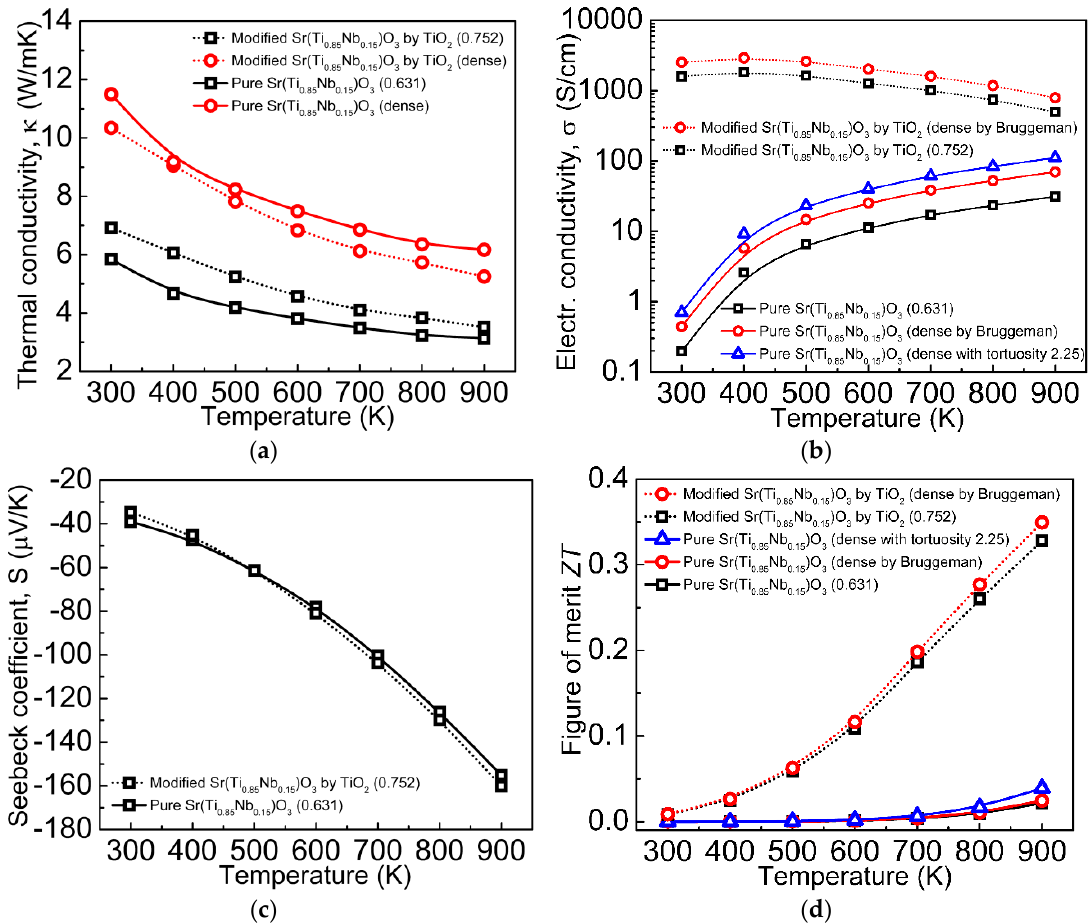
Figure 9. Temperature-dependent thermoelectric properties of Nb − SrTiO 3 ceramics obtained from submicron Sr(Ti 0.85 Nb 0.15 )O 3 powder either modified or non-modified with TiO 2 : ( a ) Thermal conductivity; ( b ) Electrical conductivity; ( c ) Seebeck coefficient; ( d ) Figure of merit ZT . © 2016 Li E, Wang N, He H, Chen H. Published in [110] under CC BY 4.0 license. Available from https://doi.org/10.1186/s11671-016-1407-8.